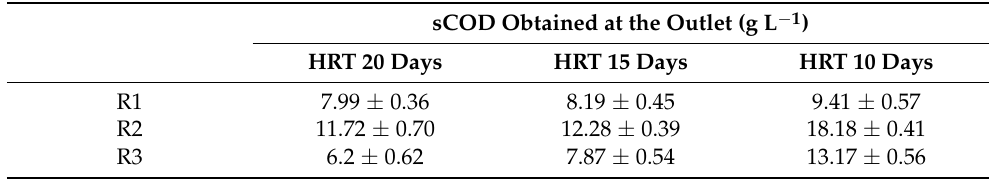
Table 3. sCOD obtained at the outlet of the R1, R2 and R3 digesters at 20, 15 and 10 days of